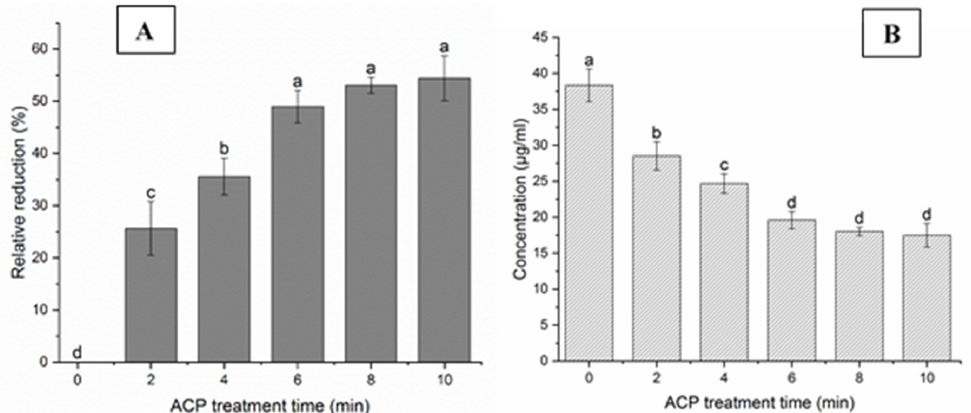
Figure 2. Effect of ACP treatment on ( A ) relative deoxynivalenol reduction % and ( B ) deoxynivalenol concentration ( µ g / mL) on barley. Data are shown as least square means ± standard deviations. Values